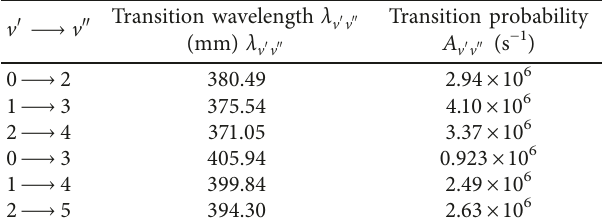
Table 1: Spectral parameters for calculating electron temperature [24].